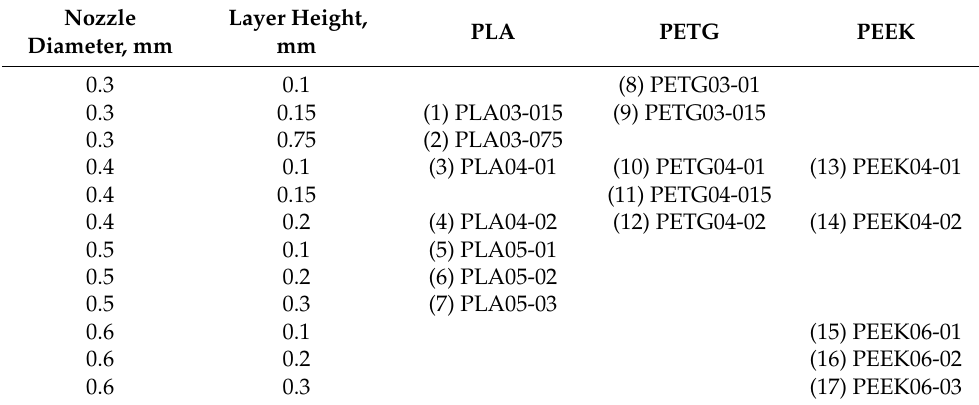
Table 1. Studied samples of polymers with respective